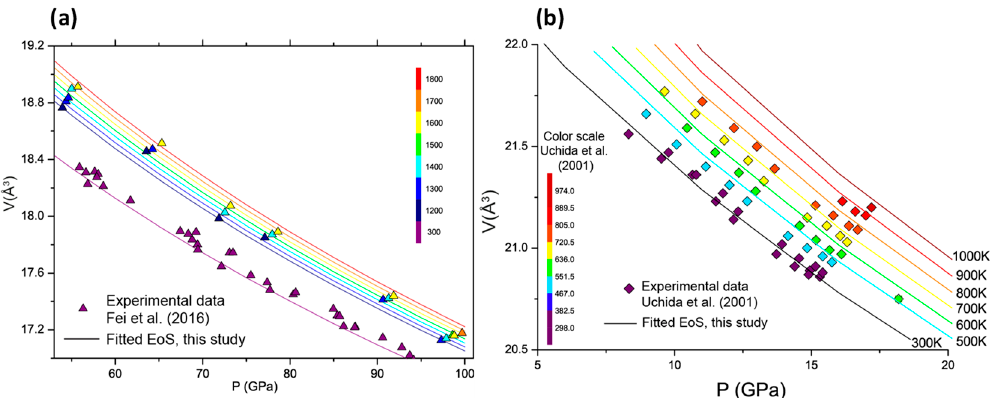
Figure 5. Volume over pressure plots of the isotherms from the present study compared with experimental data points from literature. ( a ) Data points from diamond anvil cell experiments [21]; ( b ) data points from multi anvil experiments [19].